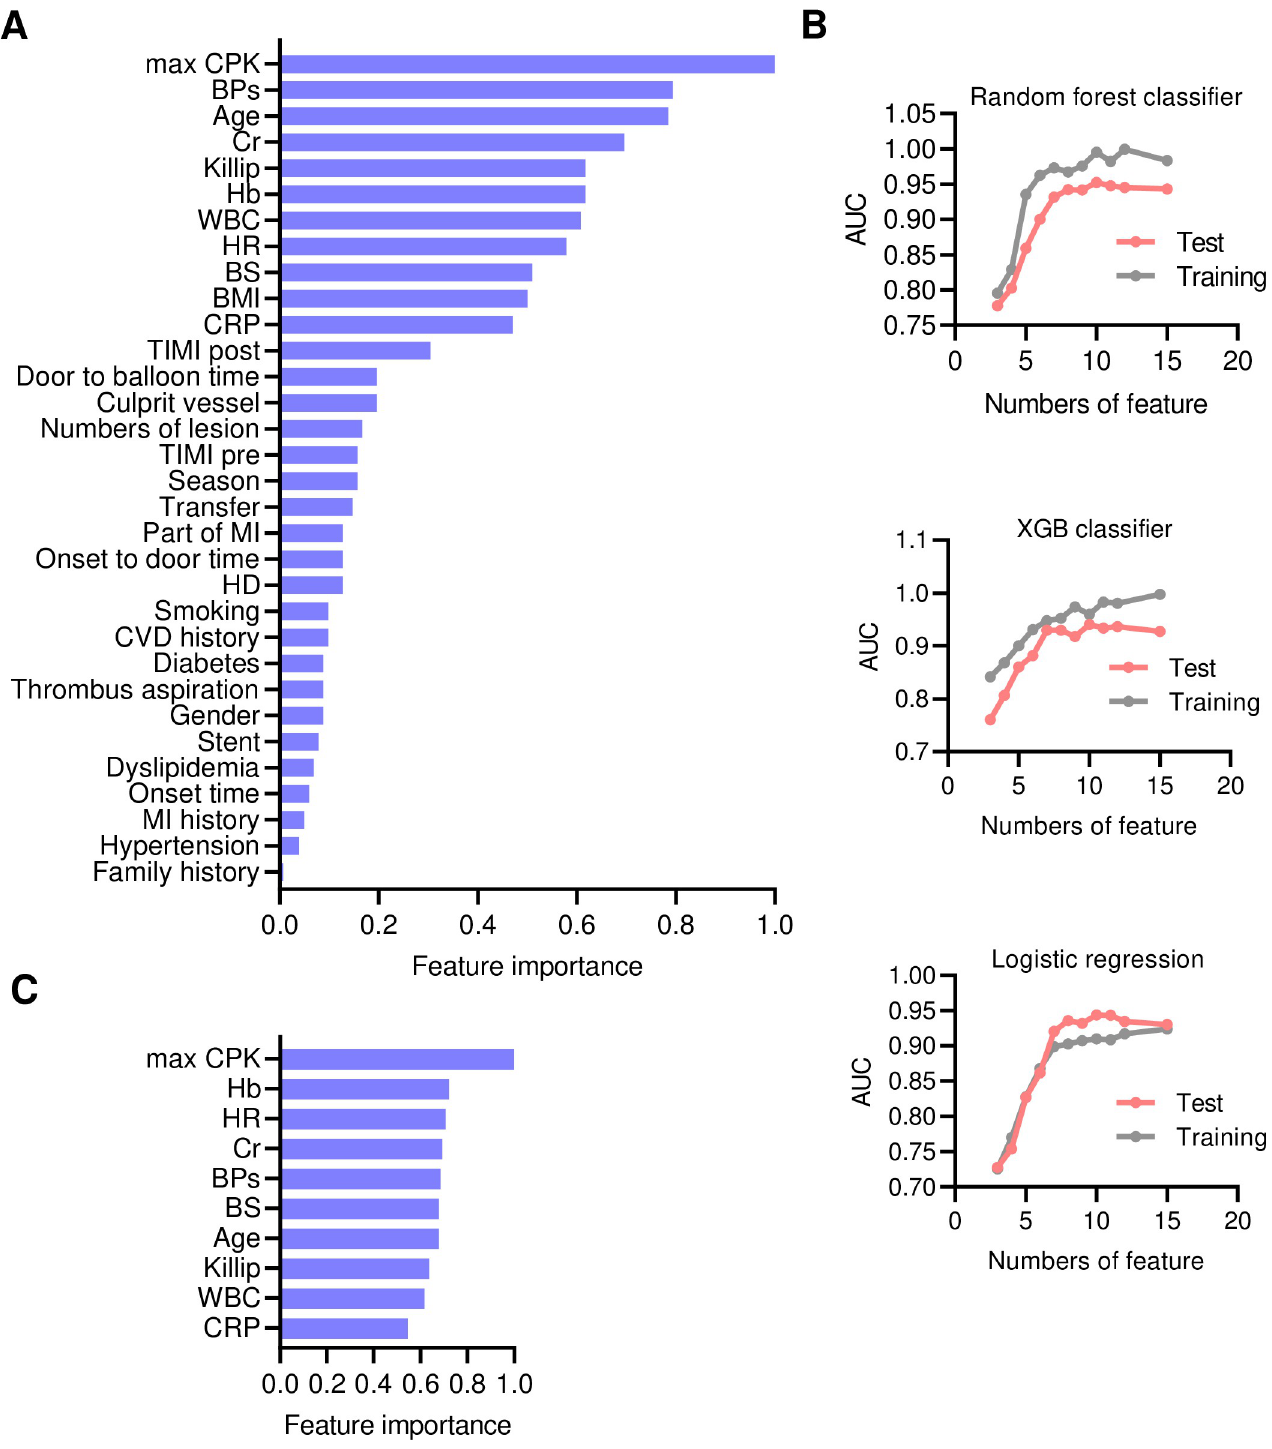
Fig 2. Feature selection of prognostic prediction model for acute myocardial infarction. A, Feature importance for all features. B, Area under the curve (AUC) for each feature numbers for training and test subsets in random forest classifier, XGB classifier, and logistic regression. C, Feature importance for selected best feature